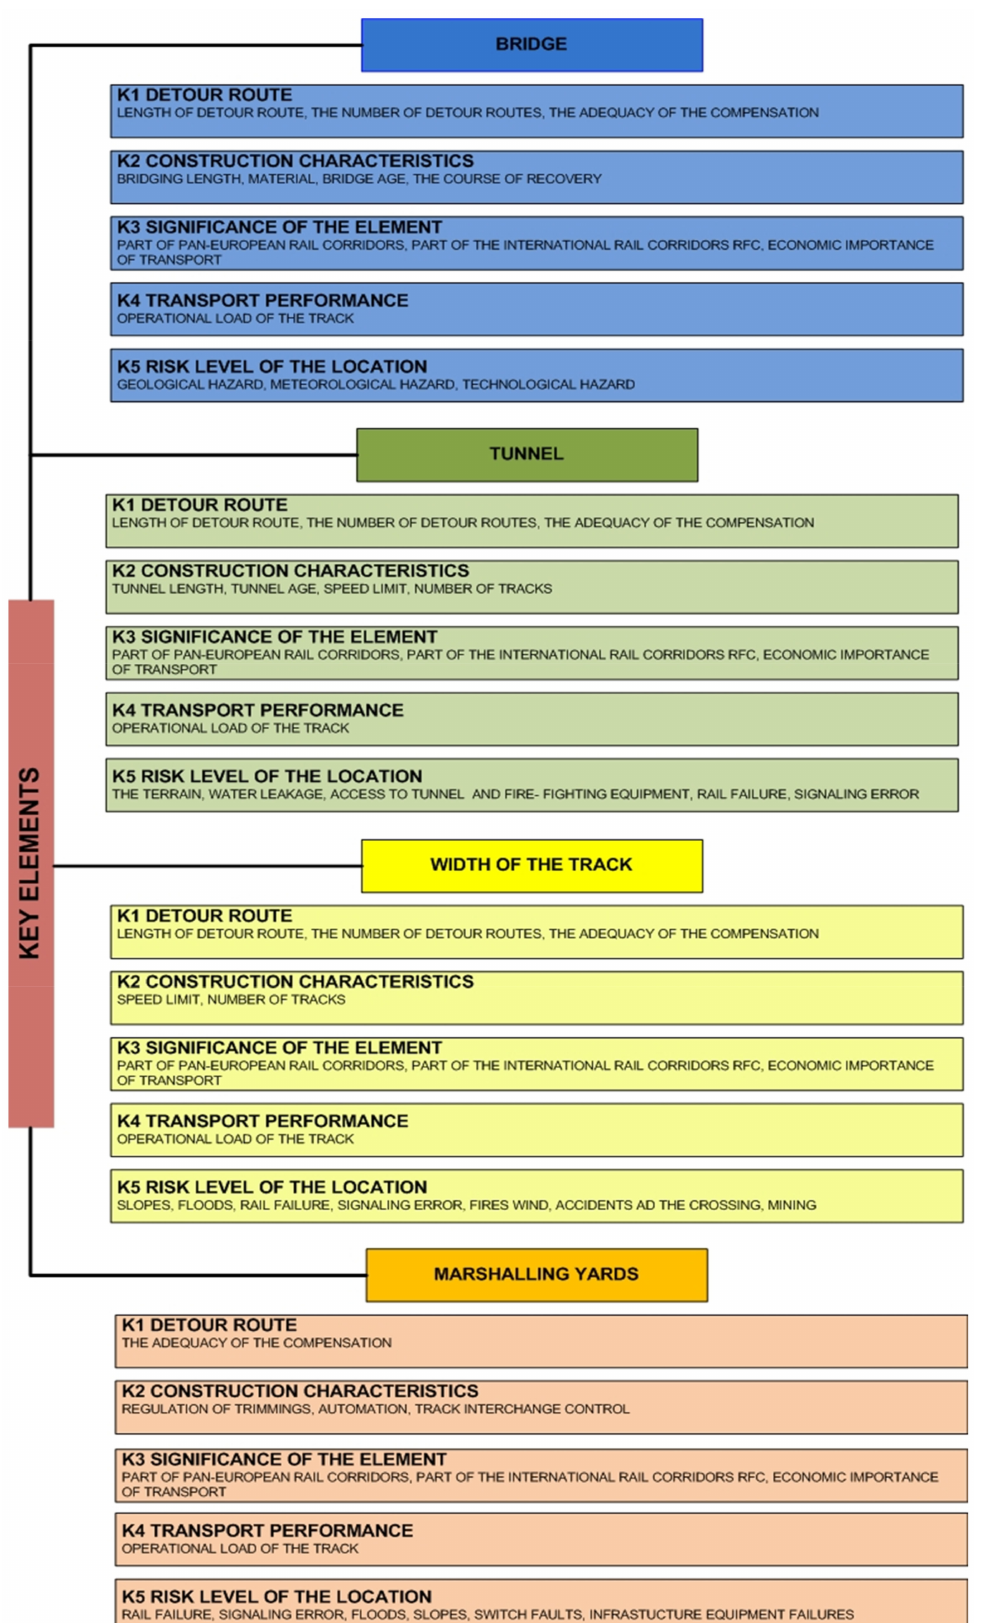
Figure 4. Evaluation parameters for key